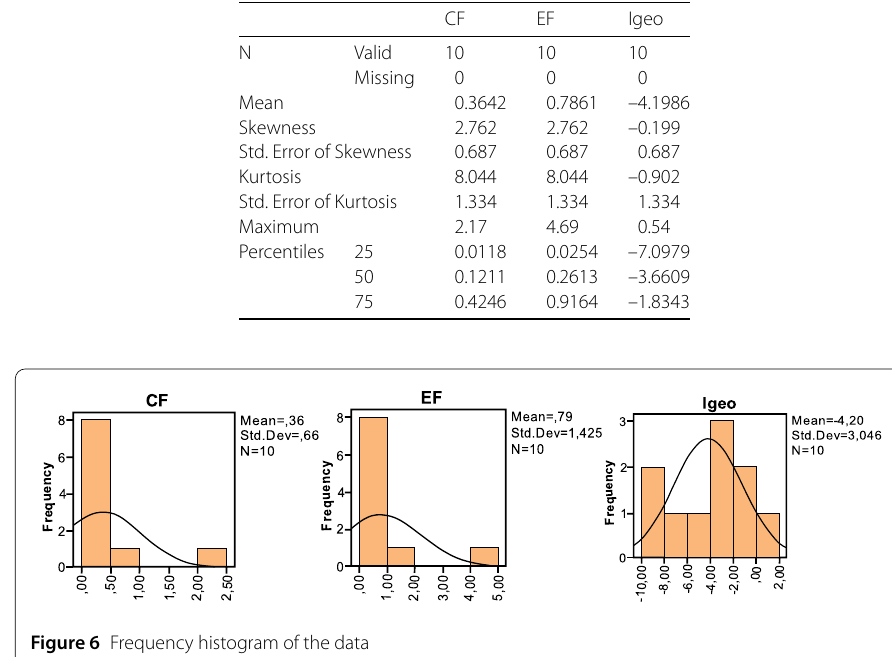
≤ 1.42 ), Fe (max. 0.535 value), unpolluted Max